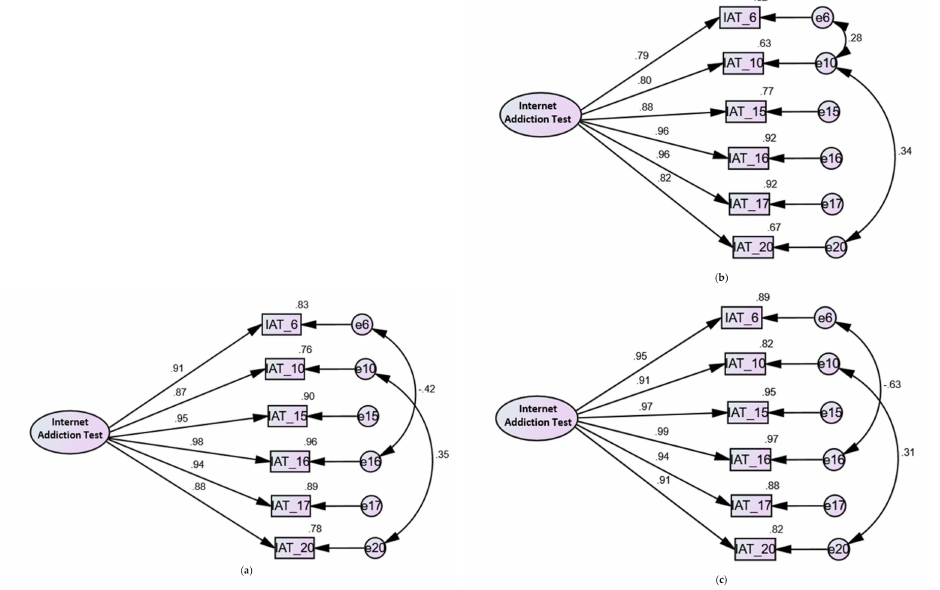
Figure 1. Factor structure of the six-item version of the Internet Addiction Test, Model 19, among all women with eating disorders ( a ), women with anorexia nervosa ( b ), and women with other eating disorders ( c ). IAT: Internet Addiction